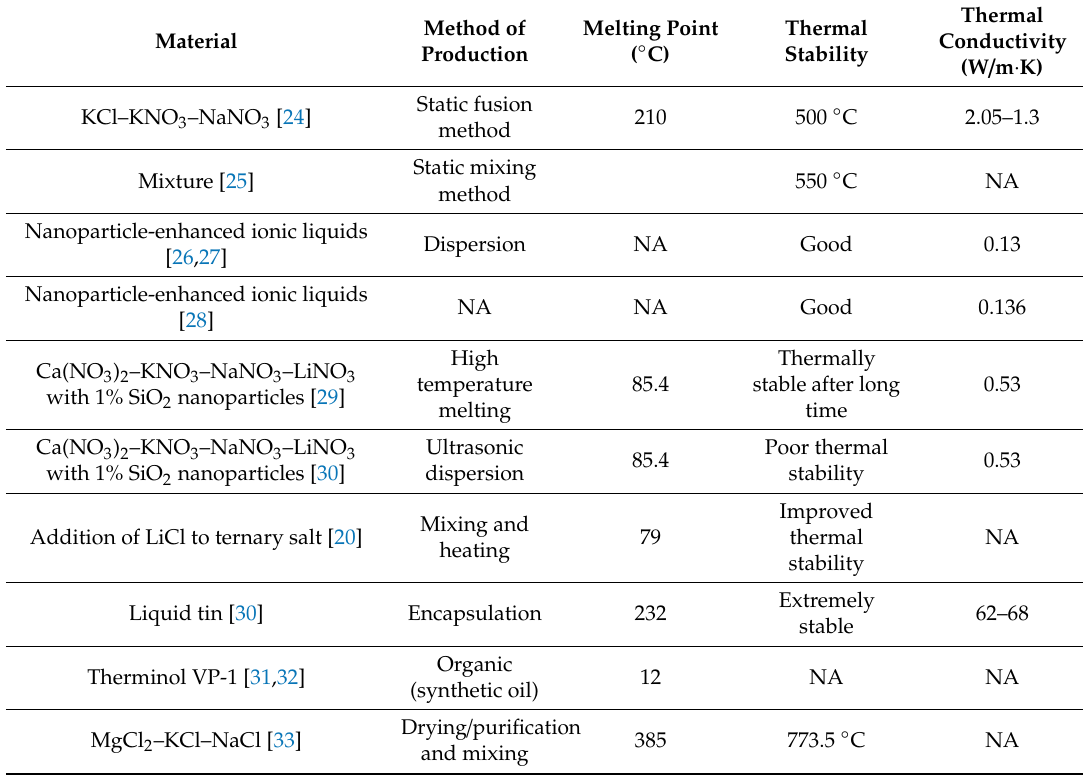
Table 1. Summary of thermal fluids including their